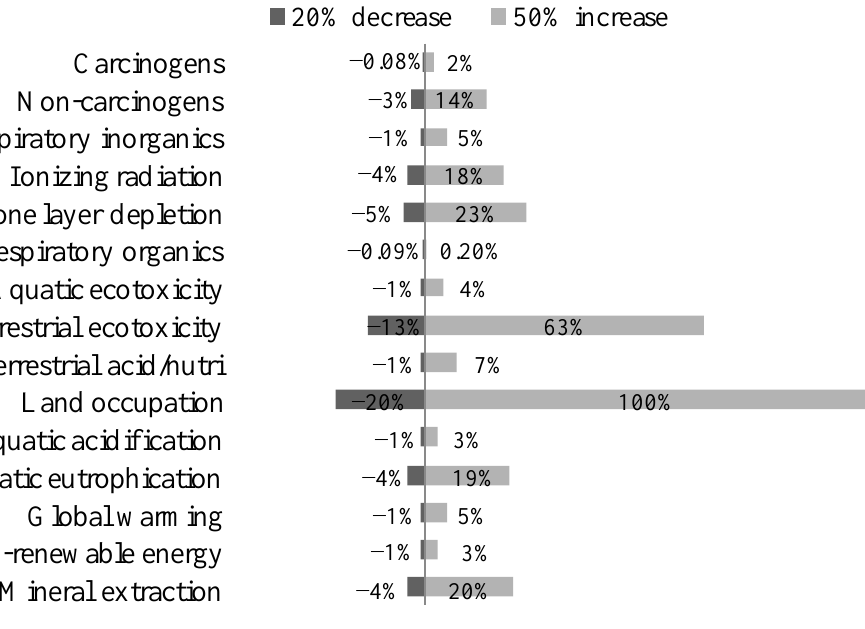
Figure 8. Land use adjustment in switchgrass.